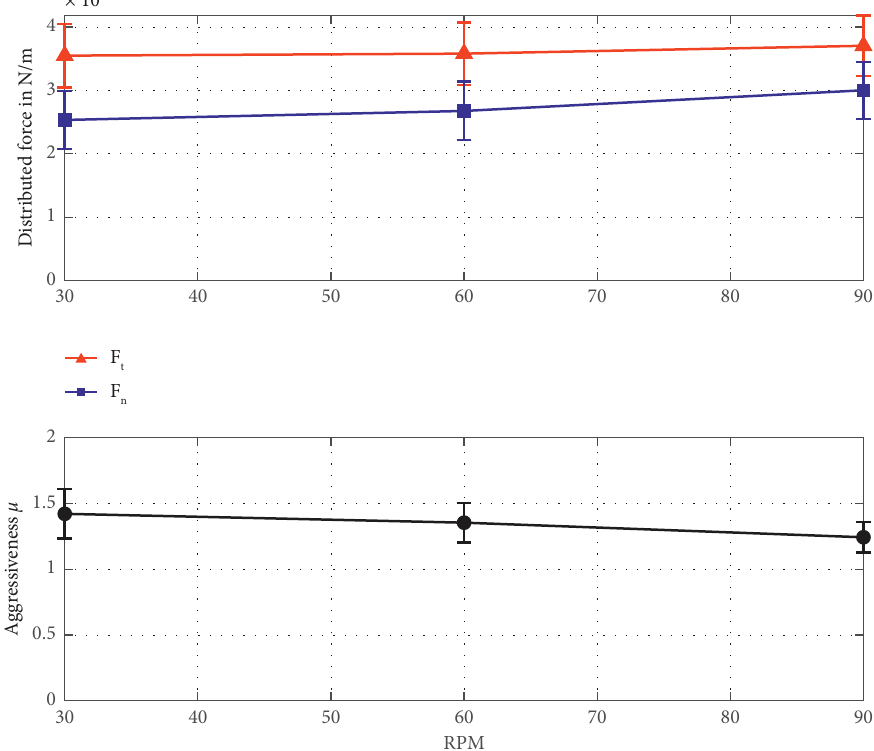
Figure 12: Averaged forces and aggressiveness at various cutting speeds using the model with rate-dependent grain elastoplasticity.